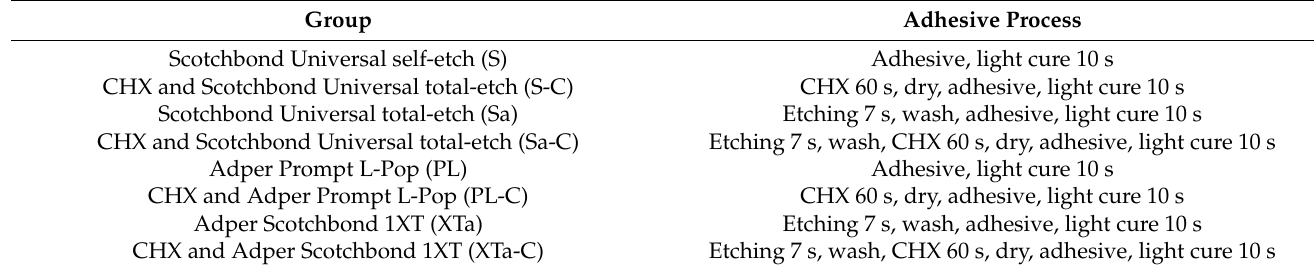
Table 1. Groups and according adhesive